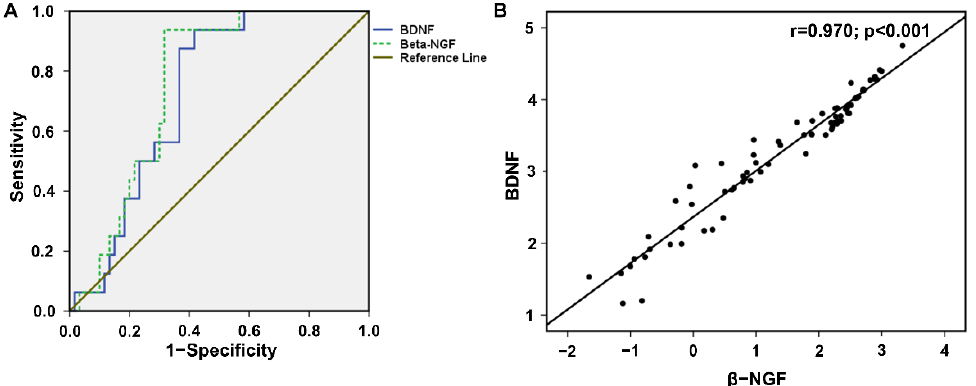
Figure 4. ( A ) The receiver operating characteristics (ROC) curve shows the area under the curve (AUC) and the cutoff value of salivary BDNF and NGF. The diagonal line is the reference line with specificity and sensitivity. ( B ) The scatter plot shows the association of neurotrophins BDNF and β -NGF.